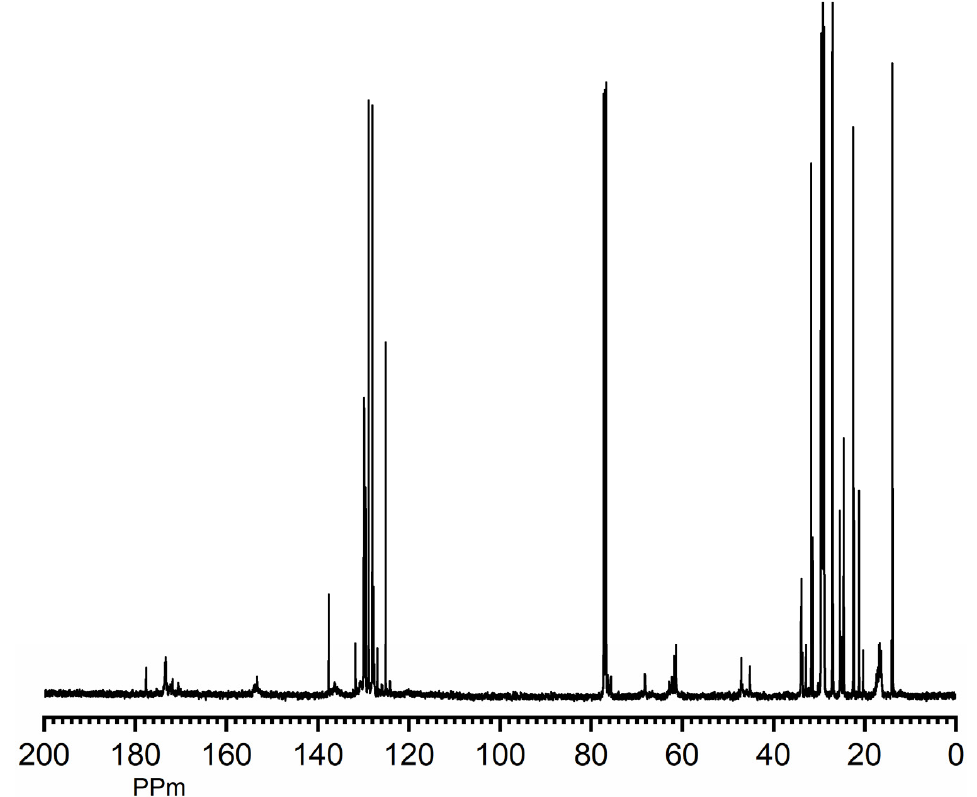
Figure 3. 13 CNMR spectrum of CPEEUA for structure elucidation.